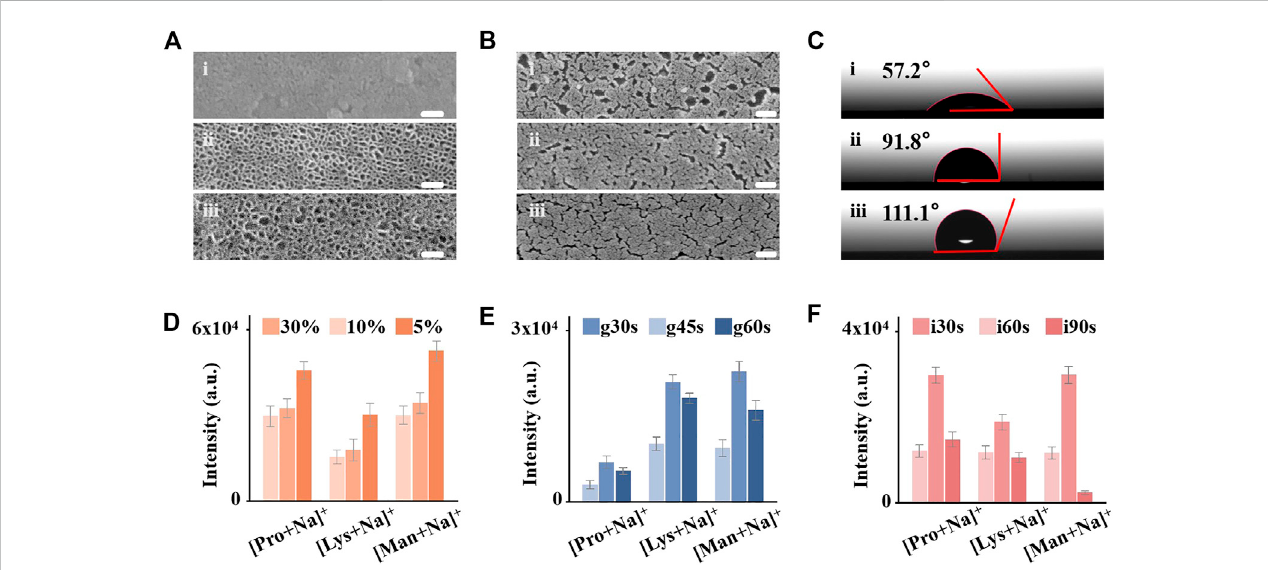
FIGURE 2 Control and optimization of IGMSM chip structural parameters. (A) Top-view image of SEM of mesoporous silica membranes on chip 30% 1), chip 10% 2), andchip 5% 3)(Scalebaris60 nm). (B) Top-viewimageofSEMofAuislandswithdifferentsputteringtimesonchip g30s 1),chip g45s 2),andchip g60s 3)(Scalebaris 100 nm). (C) Contactanglesofthechip i30s 1),chip i60s 2),andchip i90s 3).MeanintensitiesofNaadductedpeaksfor1 mg/mLproline,lysine,andmannitolon